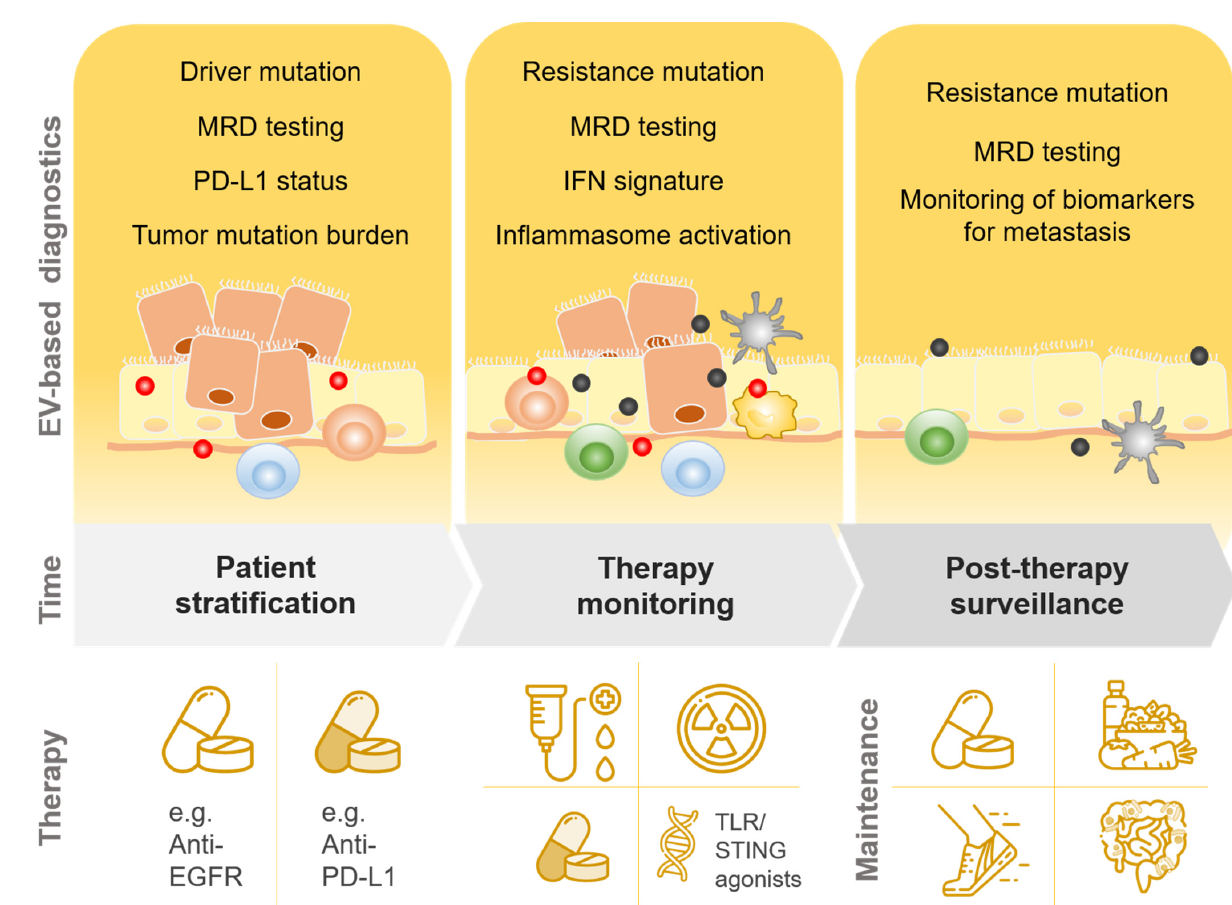
Figure 2. Potential integration of EV-based diagnostics in individualized cancer therapy. Abbreviations: EV, extracellular vesicles; MRD, Minimal residual disease; PD-L1 programmed death-ligand 1; IFN, interferon; EGFR, epidermal growth factor receptor; TLR, Toll-like receptors; STING, Stimulator of interferon genes.